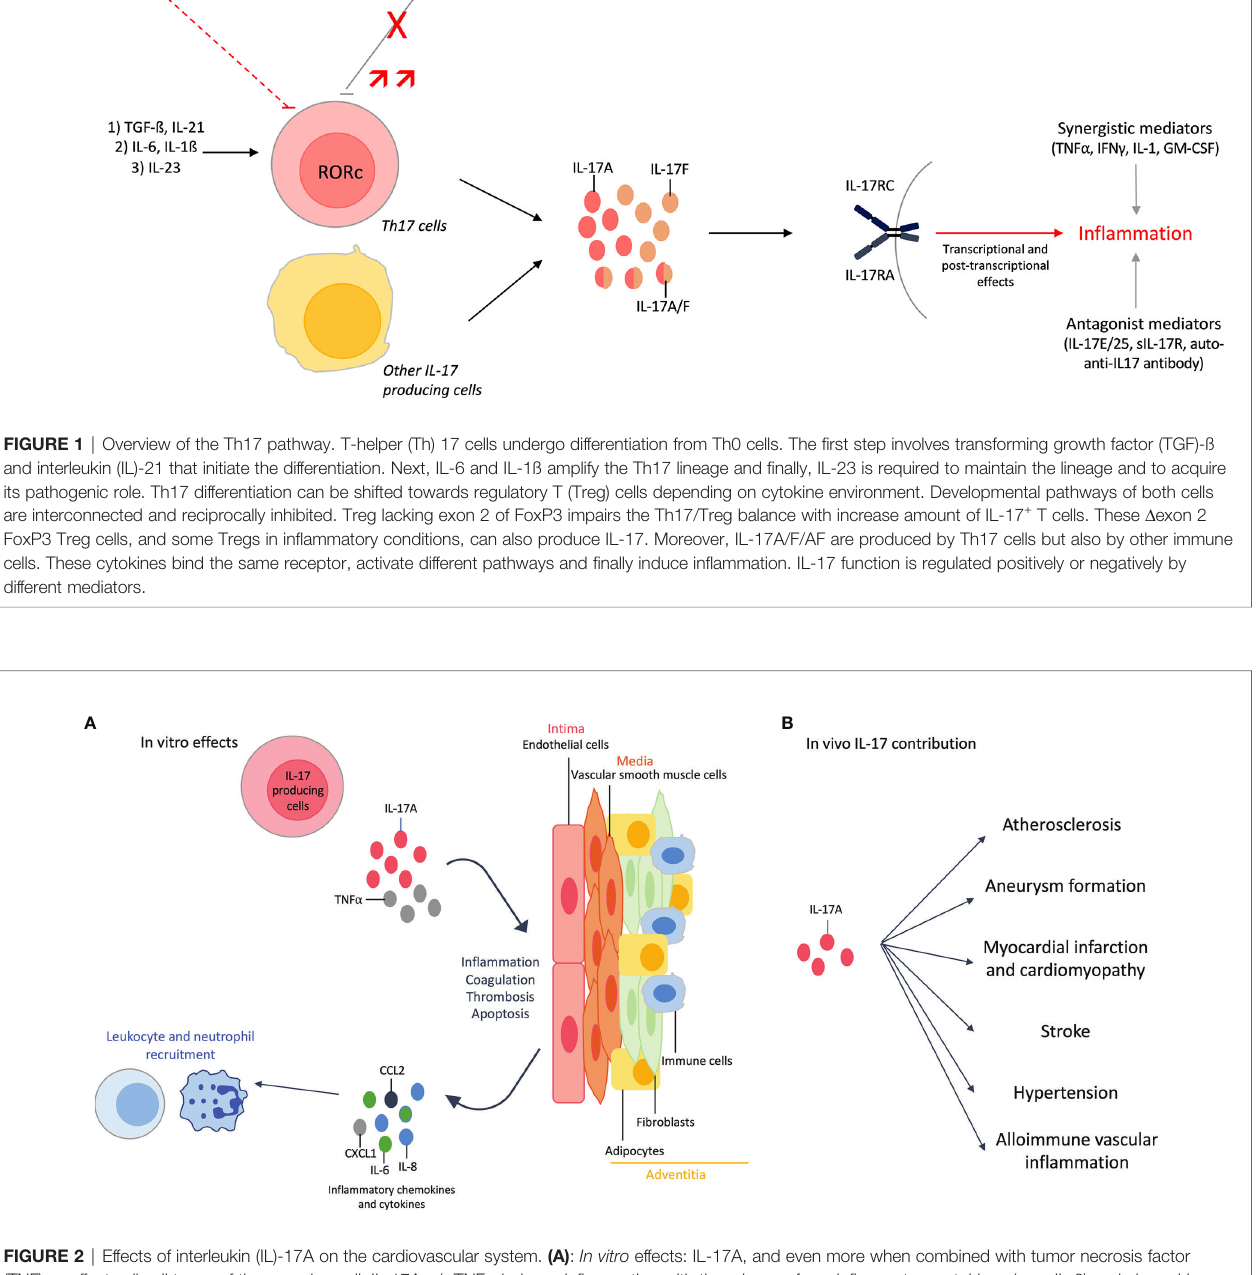
FIGURE 2 | Effects of interleukin (IL)-17A on the cardiovascular system. (A) : In vitro effects: IL-17A, and even more when combined with tumor necrosis factor (TNF)- a , affects all cell types of the vascular wall. IL-17A +/- TNF a induces in fl ammation with the release of pro-in fl ammatory cytokines (e.g., IL-6) and chemokines (e.g., IL-8, chemokine C-X-C motif ligand 1 CXCL1, C-C Motif Chemokine Ligand 2 CCL2), that in turn enhances neutrophil and leukocyte recruitment. This recruitment is also favored by the increased expression of adhesion molecules. IL-17A induces thrombosis, coagulation and apoptosis. The effects on adipocytes participate to the in fl ammatory environment. (B) : In vivo contribution of IL-17A results in accelerated atherosclerosis, aneurysm formation, myocardial infarction and cardiomyopathy, stroke, hypertension and allo-immune vascular in fl